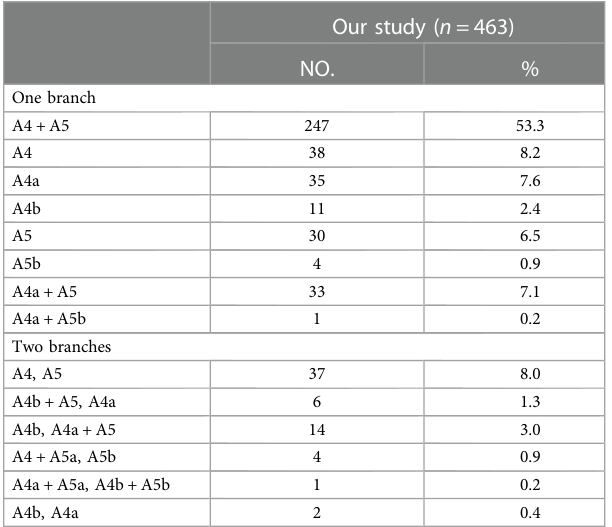
TABLE 6 The supplying range of the PI. TABLE 7 The supplying range of the PÍ.